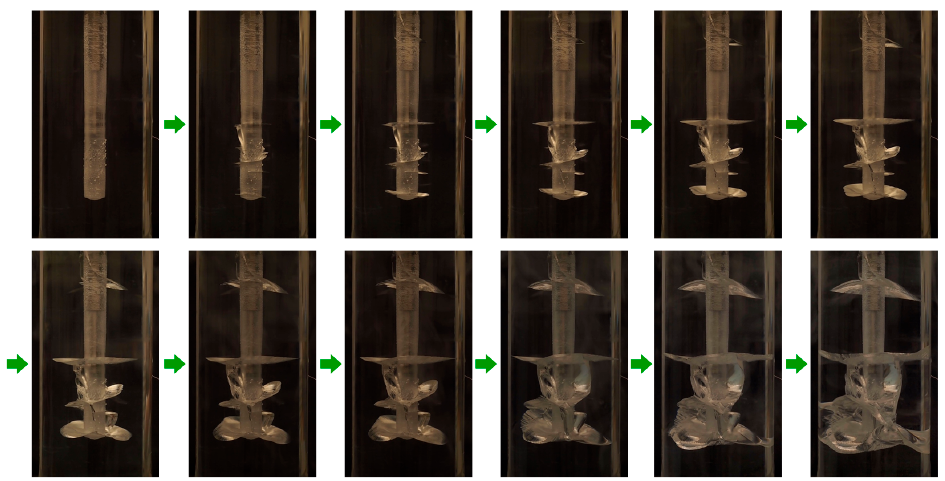
Figure 5. Crack development in Specimen 1. The pictures do not represent all of the crack growth steps.